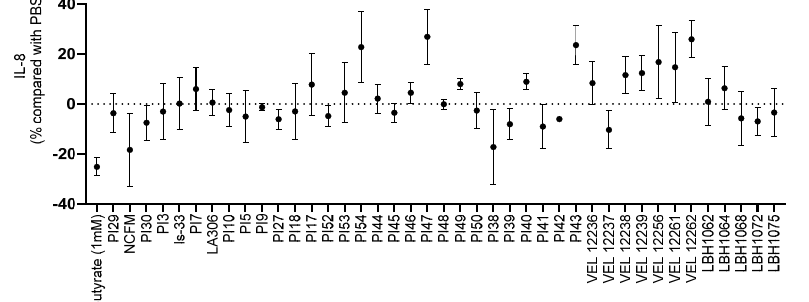
Figure 3. IL-8 production by TNF- α stimulated HT-29 cells in co-incubation with the tested strains compared with co-incubation with PBS glycerol only. Percentages below 0 indicate that the strain has reduced IL-8 production compared to the action of PBS glycerol and hence an anti-inflammatory potential; similarly, percentages greater than 0 indicate a pro-inflammatory potential according to this test. Each strain was tested with 3 independent cultures (3 biological replicates) in technical triplicates. Data are shown as mean ±